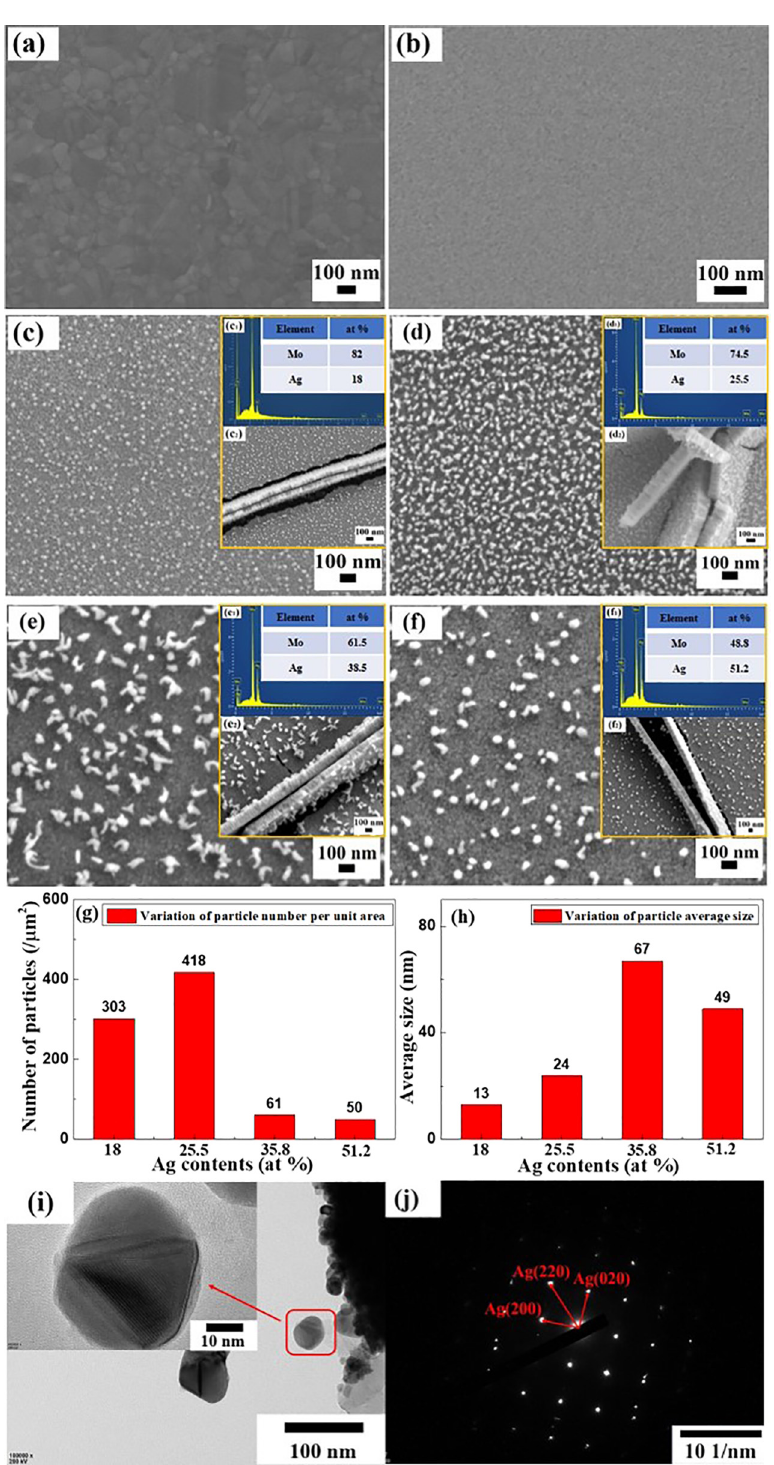
Figure 2: ( a ) Surface morphology of the Ag fi lm. ( b ) Surface morphology of the Mo fi lm. ( c ) SEM image, ( c 1 ) EDS spectrum and ( c 2 ) cross - sectional morphology of the Mo - 18.0 at% Ag fi lms. ( d ) SEM image, ( d 1 ) EDS spectrum and ( d 2 ) cross - sectional morphology of the Mo - 25.5 at % Ag fi lms. ( e ) SEM image, ( e 1 ) EDS spectrum and ( e 2 ) cross - sectional morphology of the Mo - 38.5 at% Ag fi lms. ( f ) SEM image, ( f 1 ) EDS spectrum and ( f 2 ) cross - sectional morphology of the Mo - 51.2 at% Ag fi lms. ( g ) Variation of the nanoparticle number per unit area on the fi lm surface with Ag content. ( h ) Variation of the average particle size on the fi lm surface with Ag content. ( i ) The TEM pattern of the nanoparticles/Mo – Ag alloy fi lm and nanoparticle magni fi cation. ( j ) The SAED pattern of the nanoparticle in ( i )